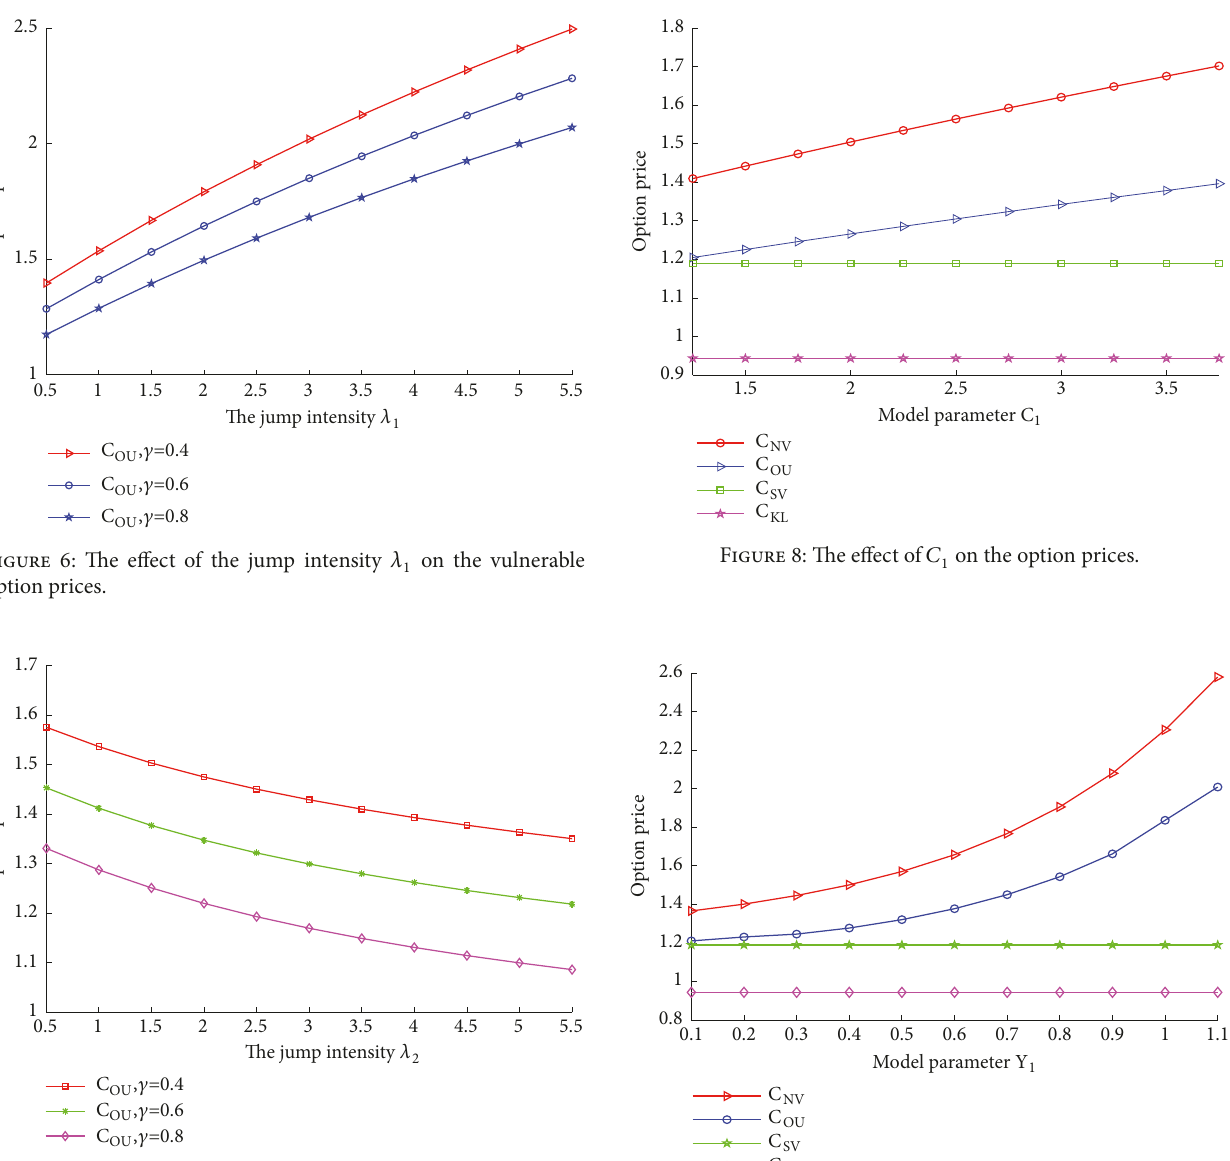
Figure 7: The effect of the jump intensity 𝜆 2 on the vulnerable option prices.